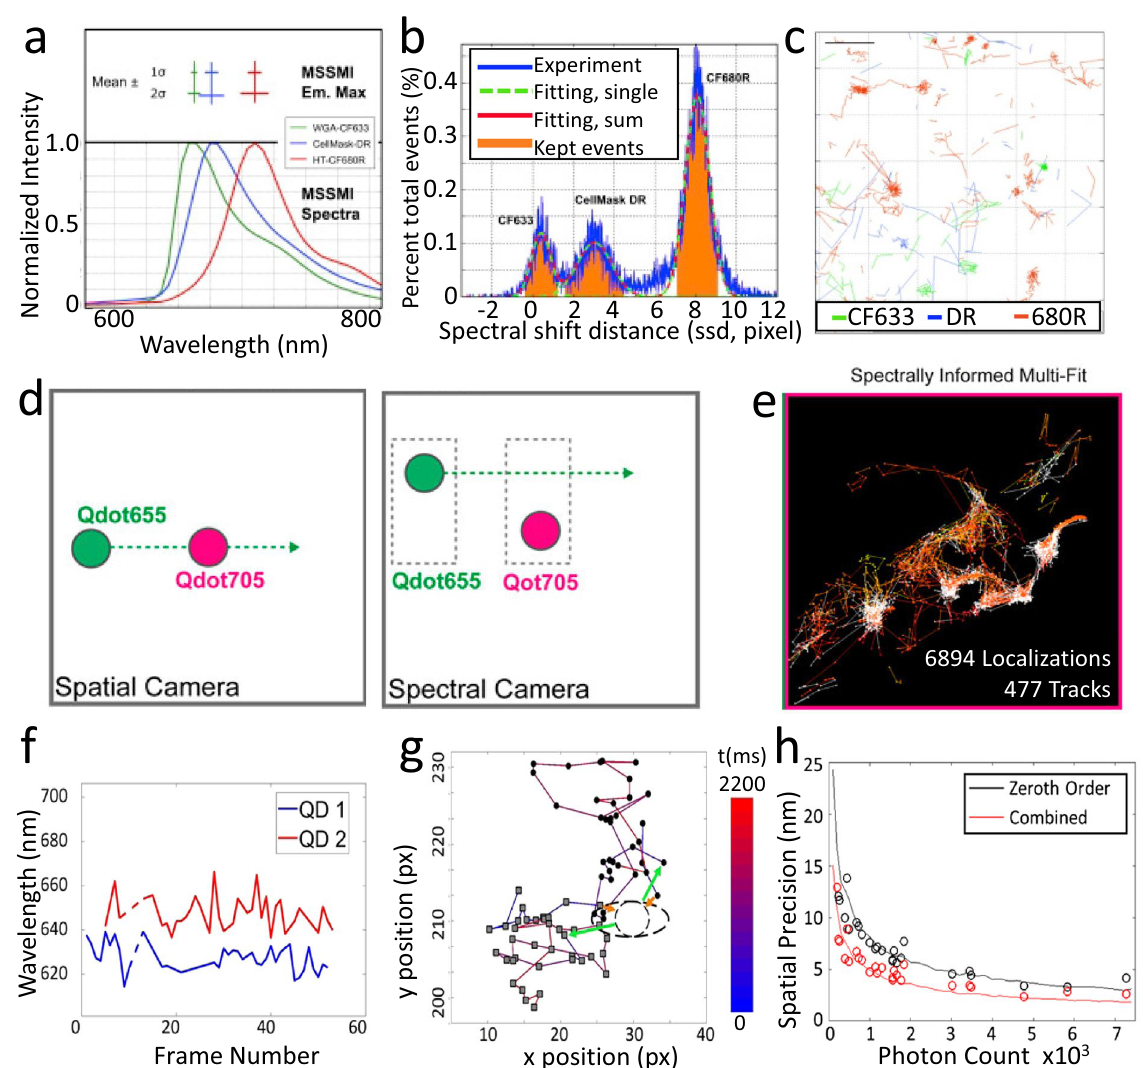
Fig. 7 a Average emission spectra of CF 633, CellMask DR, and CF680R; b Histogram of identified spectral centroids showing each fluorophore species resolved into a separated spectral peak. c Multiplexed SPT in U2OS cells. Reprinted with permission from [60]; d Illustration of sSMLM tracking two Qdot species; e Trajectories for two-color QD tracking with spectrally informed trajectory assignments. Reprinted with permission from [61]. h improved spatial precision by integrating spatial information from the spectral image in the tracking trajectory; f , g spectral tagging of individual quantum dots to separate trajectories with spatial overlapping (Reprinted with permission from